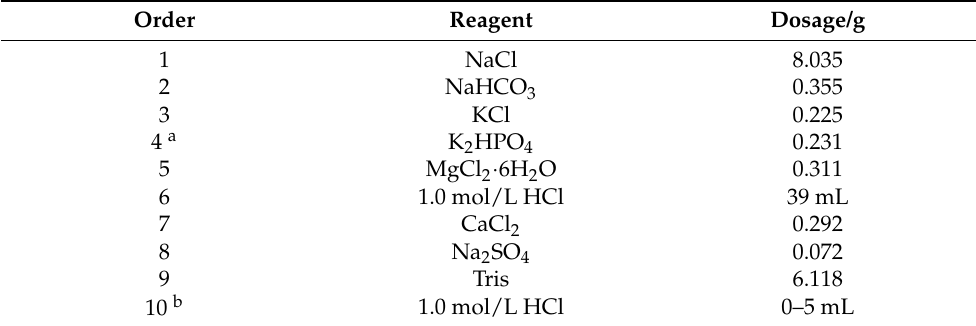
Table 3. Preparation reagent and dosage of SBF per